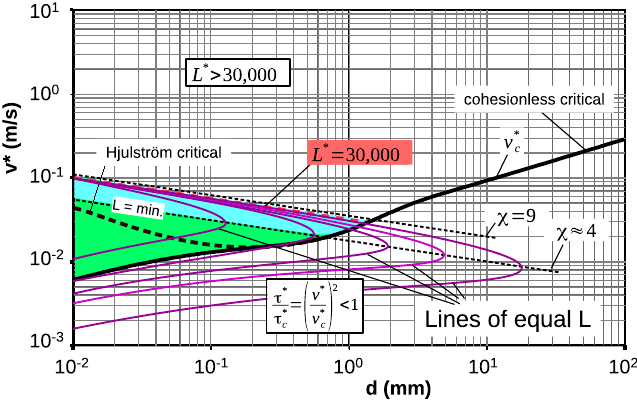
Figure 15. Ripple domain, example for the case